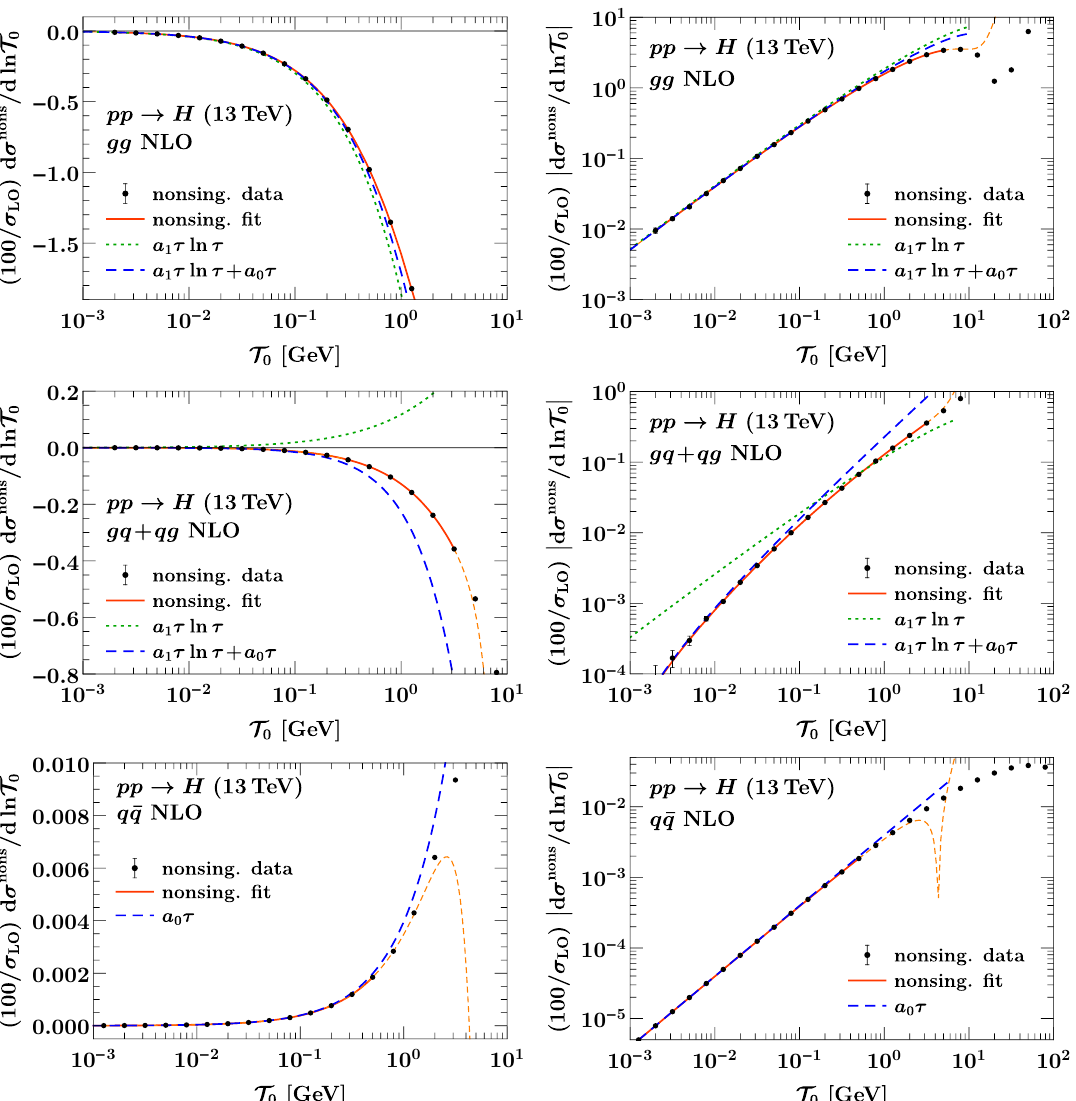
Figure 7 . The O ( (cid:11) s ) nonsingular corrections for Higgs production for the gg channel (top row), gq + qg channel (middle row), and q (cid:22) q channel (bottom row). A (cid:12)t to the nonsingular data (black dots) is shown by the solid red curve. The LL and NLL results are shown by green dotted and blue dashed curves, respectively. In all cases, the NLL approximation provides an excellent approximation to the complete nonsingular cross section for su(cid:14)ciently small T 0 .